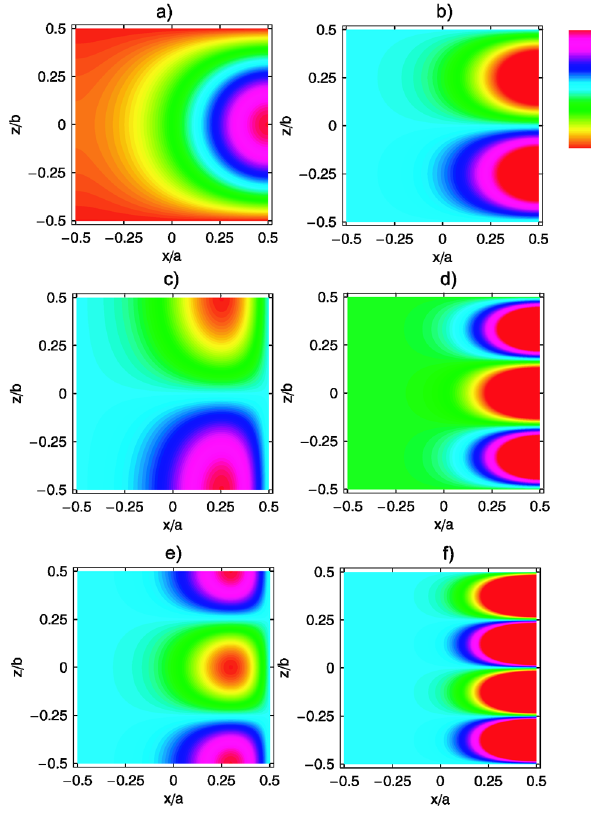
FIG. 3. (Color) Field patterns for a square cross section of the mode, m (cid:1) 0 , p (cid:1) 1 ; (b) E mode, m (cid:1) 0 , waveguide: (a) E r r p (cid:1) 2 ; (c) E mode, m (cid:1) 1 , p (cid:1) 1 ; (d) E mode, m (cid:1) 0 , p (cid:1) 3 ; z r mode, m (cid:1) 1 , p (cid:1) 2 ; (f) E mode, m (cid:1) 0 , p (cid:1) 4 . For (e) E z r modes, the graphs show distribution of the E component the E z z modes, the E distribution is shown. of the field; and for the E r r The color coding palette is shown in the upper right corner of the picture, where the bottom and the top of the palette correspond to lower and higher values, respectively. Note that the mode profiles are not normalized, and the patterns of different modes cannot be compared with each